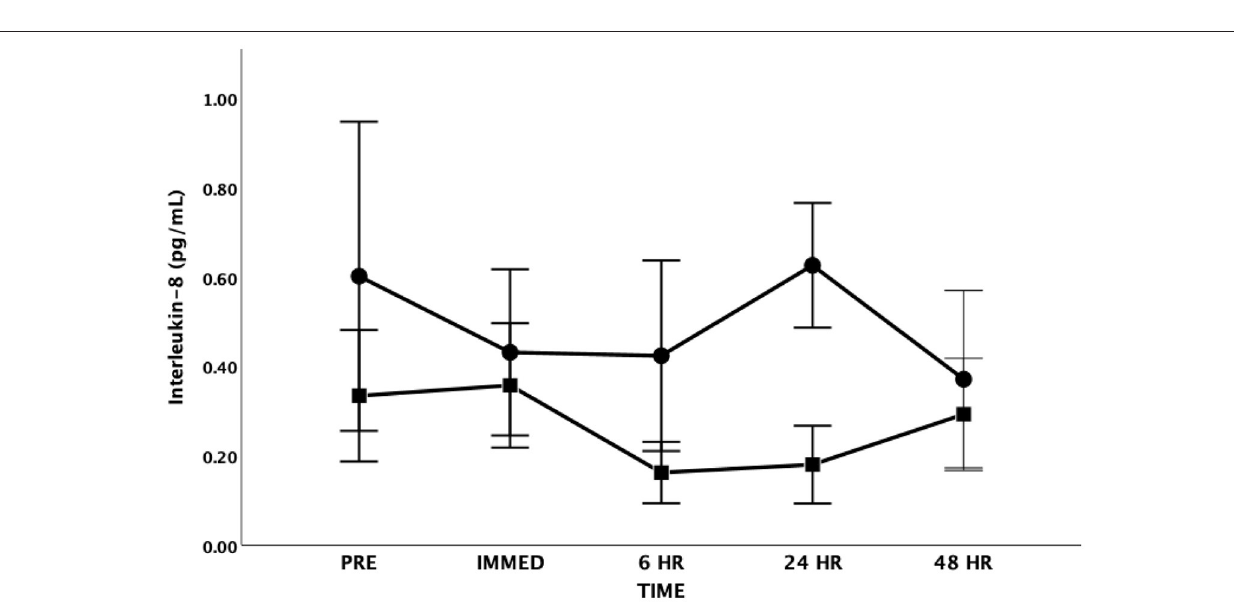
[ F (1.7, 19.8) = 1.863, p = 0.185, Partial Eta = 0.134; Observed Power = 0.314]. There were no significant differences in TNF- α at any time point [ F (4, 48) = 0.305, p = 0.873, Partial Eta = 0.025; Observed Power = 0.112] or between groups [ F (1, 12) = 0.902, p = 0.361, Partial Eta = 0.070; Observed Power = 0.141] ( Figure 5 ).